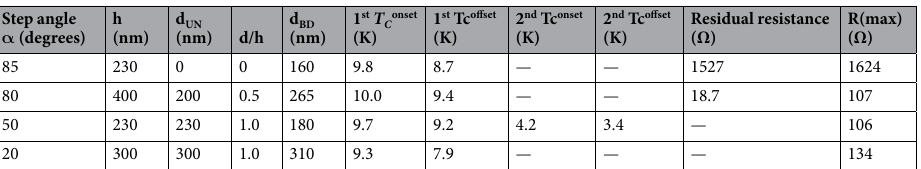
Table 1. Sample parameters, including the height of the etched step h, thickness of the undoped layer, thickness of the superconducting boron-doped layer, onset and offset first transition temperatures, onset and offset second transition temperatures, residual resistance at 2.0 K, and maximum resistance in the range of 2–300